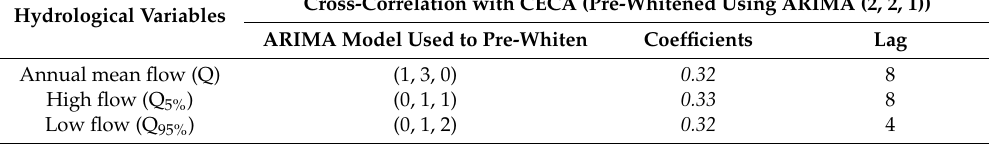
Table 3. Cross-correlation results between the residuals of logged Autoregressive Integrated Moving Average (ARIMA) time series models for cumulative equivalent clear-cut area (CECA) and annual streamflow components in the Deadman River watershed from 1960 to 2012. The bold italicised coefficient value indicates that the model is significant at p -value = 0.05. Streamflow components include annual mean flow (Q), low flow (Q 5% ), and high flow (Q 95% ). The ARIMA model used is denoted by ln(p,d,q), where ln represents that the log of the data was taken prior to running the ARIMA model, p is the order of the auto-regressive model, d is the degree of differencing, and q is the order of moving-average chosen for the ARIMA